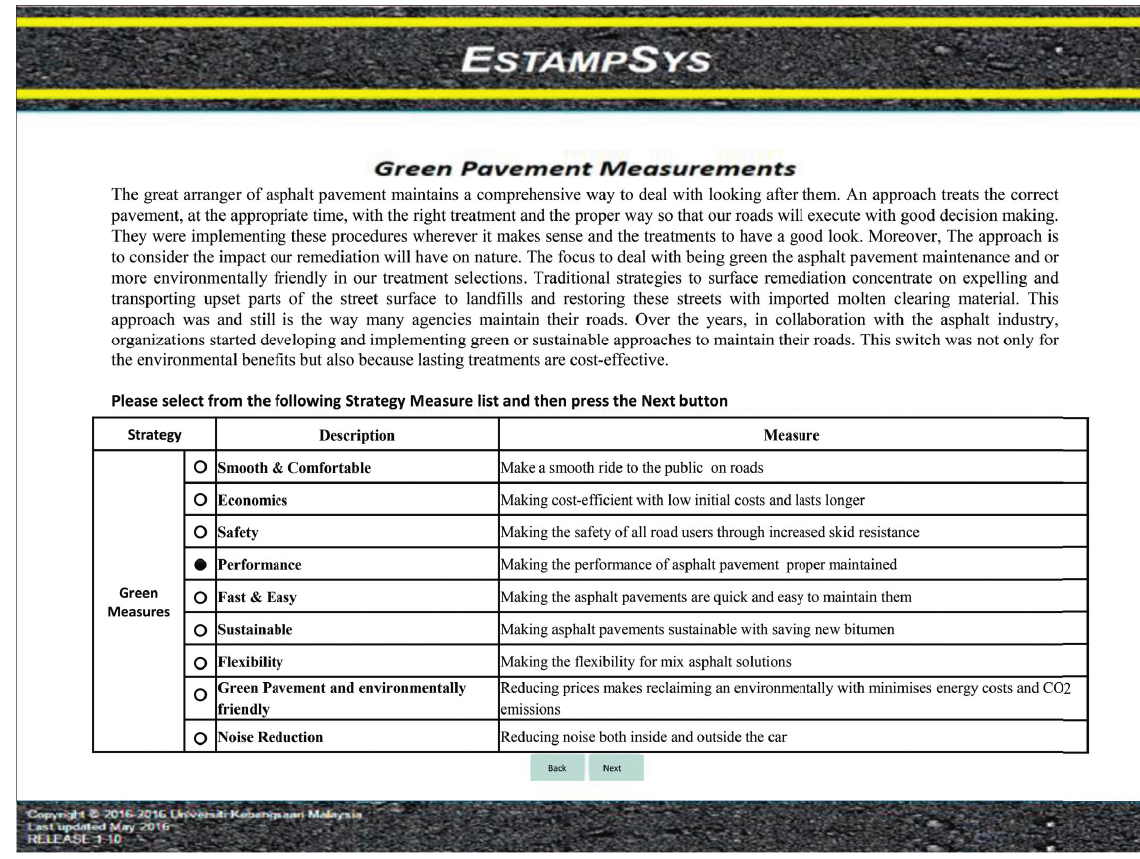
Figure 10: Screenshot of the green measurement